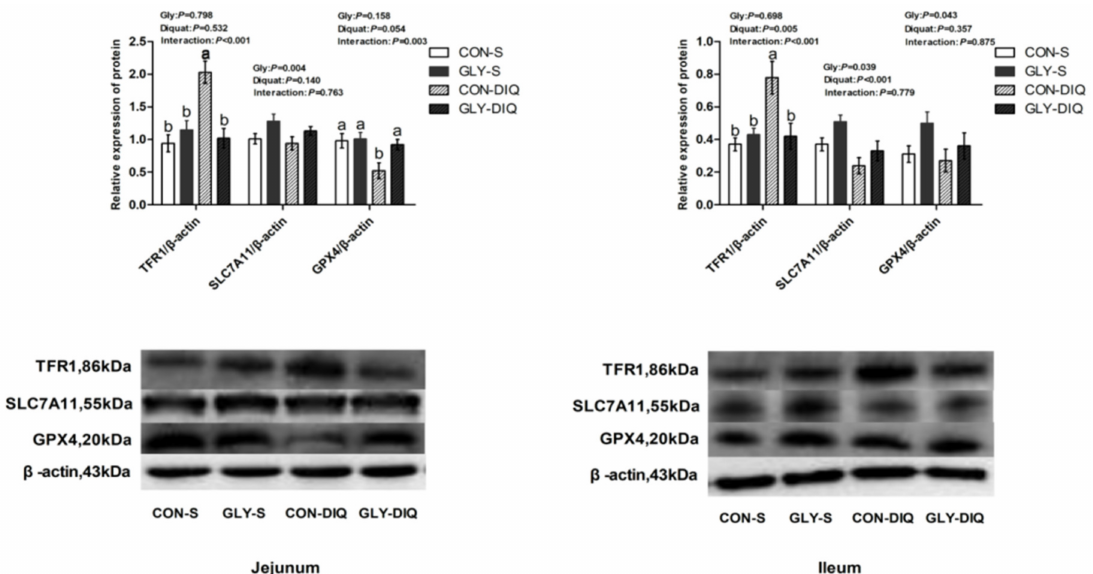
Figure 1. The abundance of ferroptosis-related proteins of jejunum and ileum in the piglets fed glycine supplementation diets under oxidative stress inspired by injected diquat. The stripes served as representational exemplars of Western blot images. Values are mean and pooled SEM, n = 8 (1 piglet per pen). CON-S, piglets fed the basal diet and injected with saline; GLY-S, piglets fed the glycine supplementation diet and injected with saline; CON-DIQ, piglets fed the basal diet and challenged with diquat; GLY-DIQ, piglets fed the glycine supplementation diet and challenged with diquat. a, b. No identical letter appears in the same row, which demonstrates that the difference is significant, p <